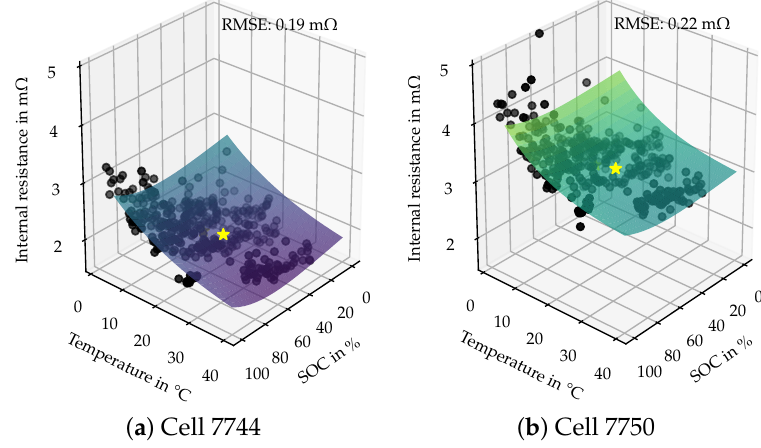
(b) Cell 7750 Figure 13. Curve fit of all samples of cell 7744 and 7750 over temperature and SOC. The SOC-axis is modeled by a polynomial and the temperature axis is modeled by an exponential relationship as Equation (2) shows. The reference point R i is marked in yellow.